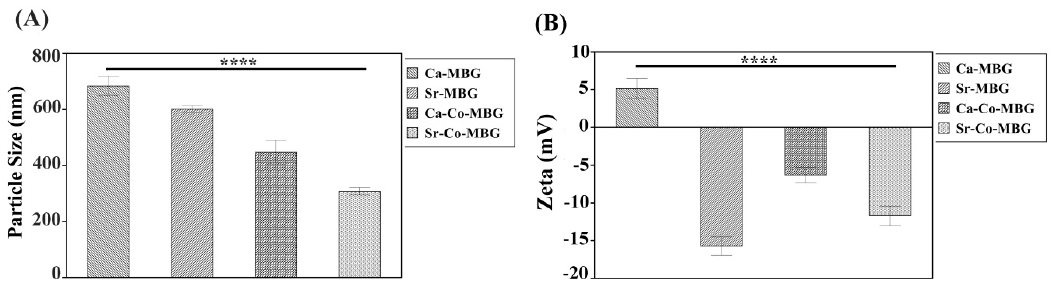
Figure 5. ( A ) DLS and ( B ) zeta potential analysis results.